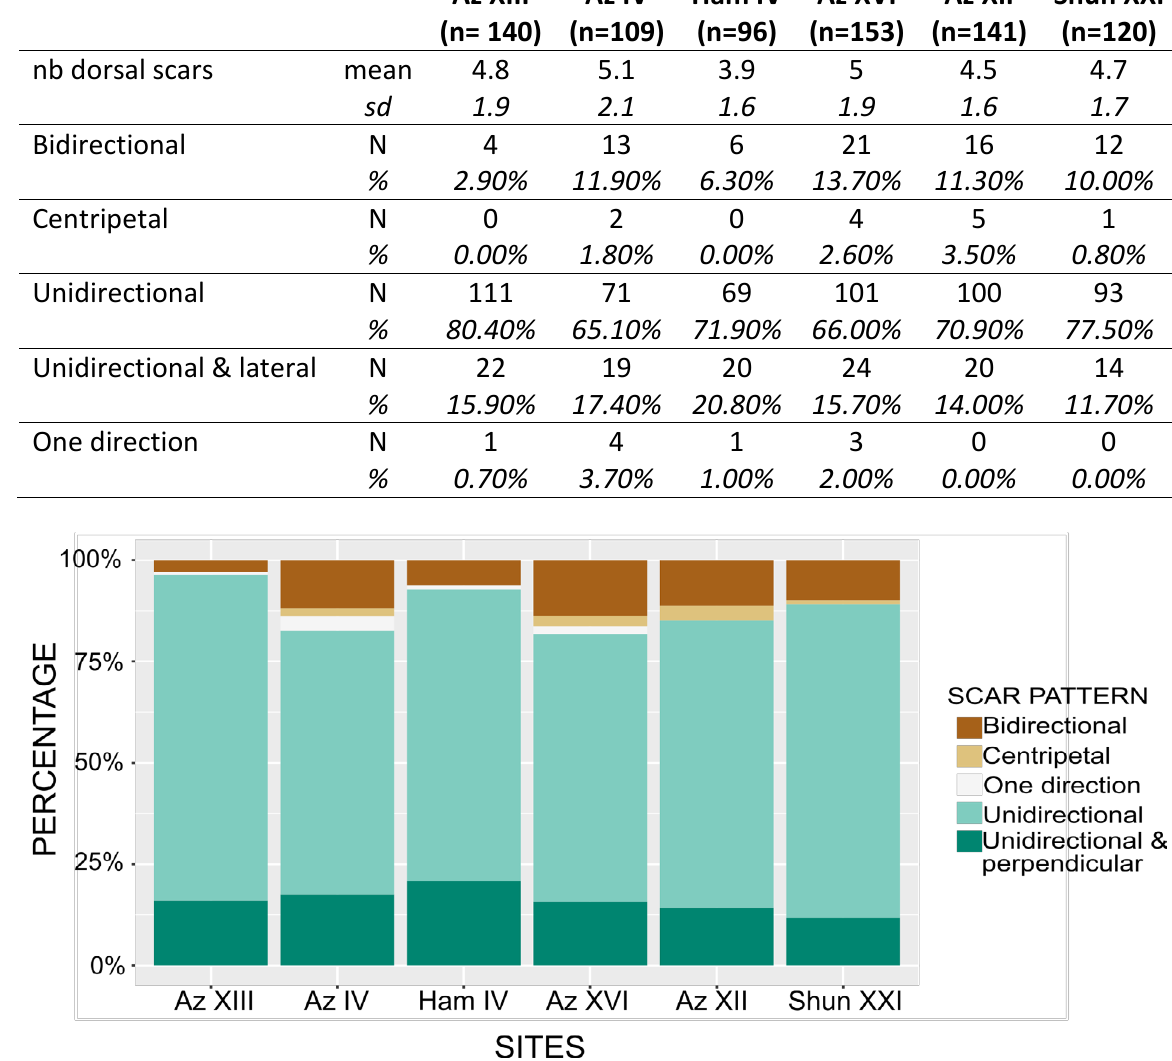
Figure 9. Relative percentages of scar patterns. Az - Azariq; Shun - Shunera; Ham -